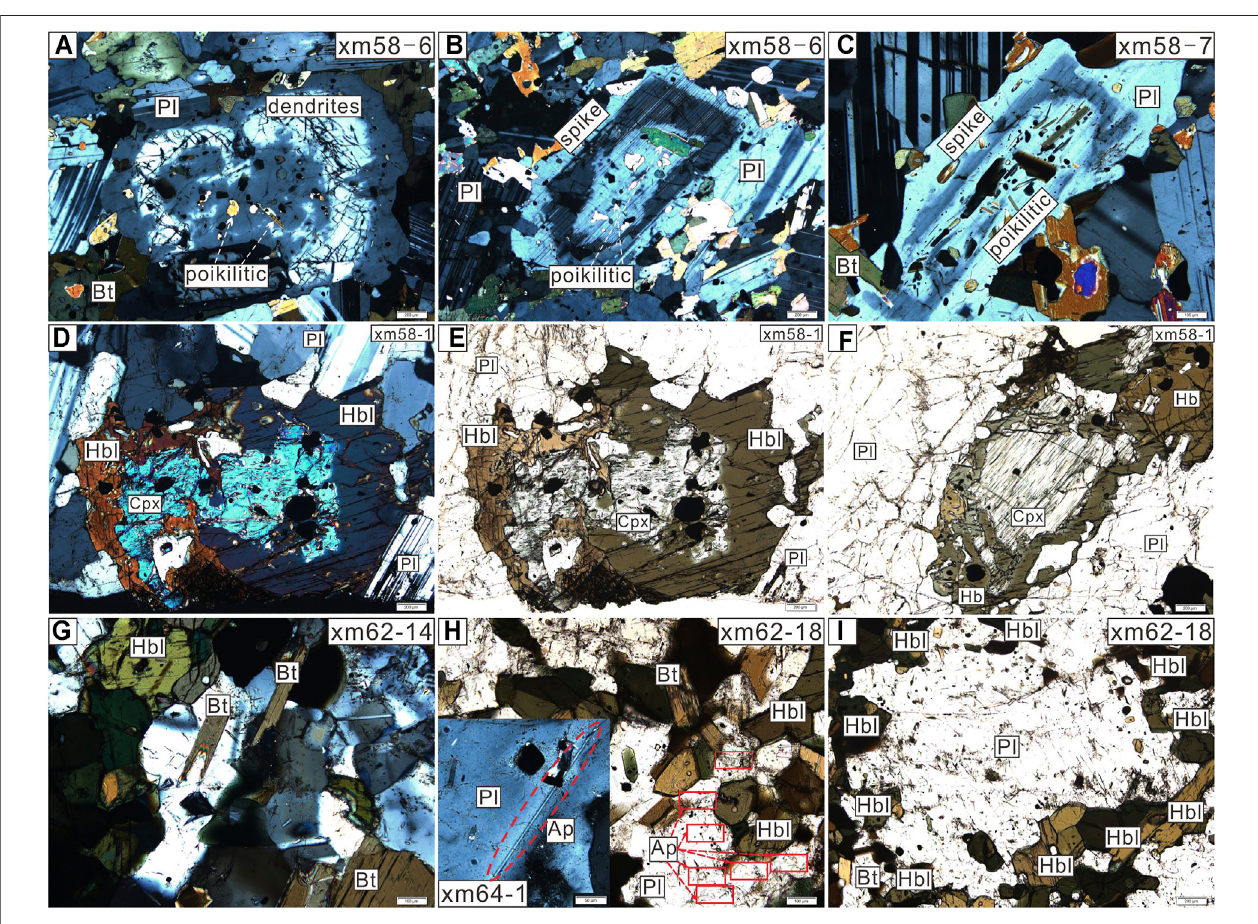
FIGURE 12 | Photomicrographs of plagioclase phenocryst, Cpx-Amp texture, bladed biotite, acicular apatite, and plagioclase ocelli in enclaves. (A – C) Photomicrographs of plagioclase phenocrysts showing discontinuous zoning, dendritic and poikilitic textures. (D – F) Cpx-Amp core-mantle texture in the enclaves. (G) Bladed biotite. (H) Acicular apatite enclosed within the plagioclase. (I) Plagioclase ocelli, mantled by small hornblende crystals and bladed biotite lathes.